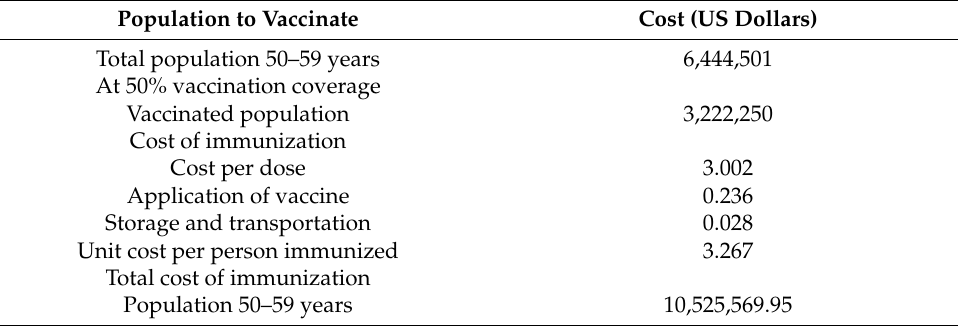
Table 8. Costs of vaccination of the target population 1 (US